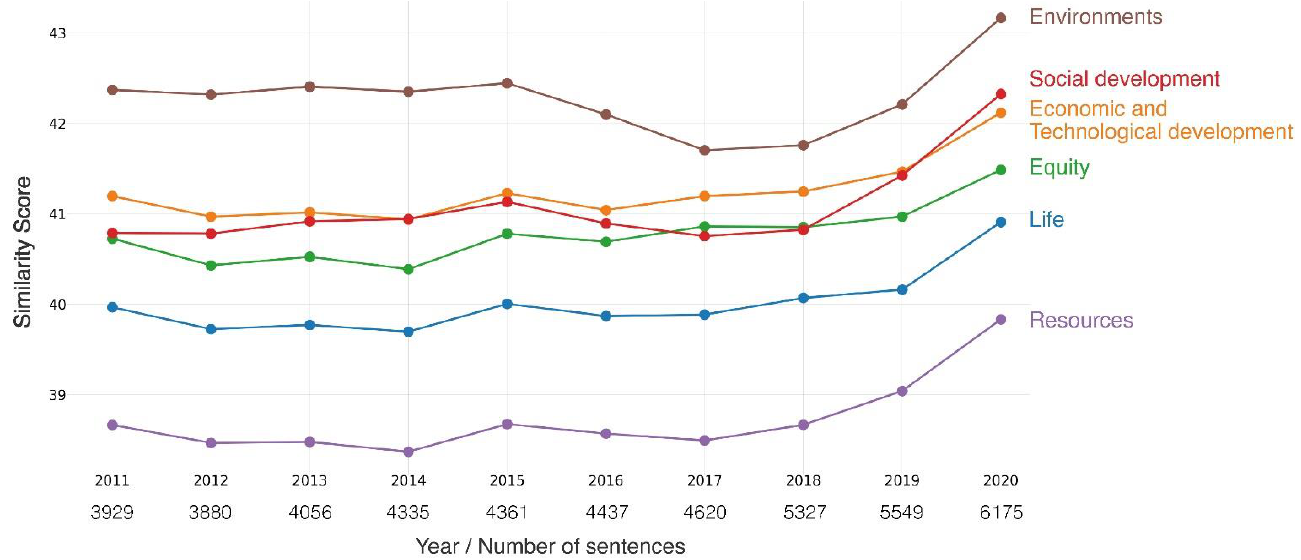
Figure 4. Thematic structure of sustainability reports: BASF.